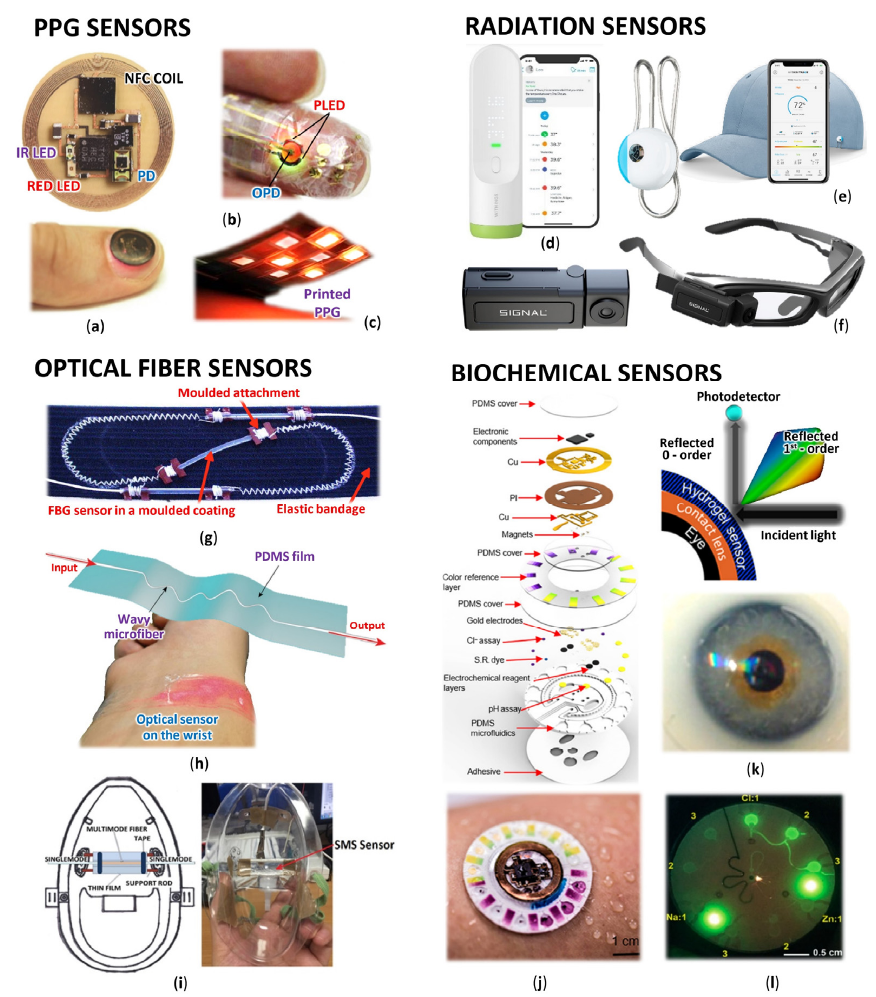
Figure 1. Wearable optical sensors for measuring of human physiology: ( a ) Miniaturized battery- free NFC enabled wireless systems for wearable pulse oximetry (unencapsulated device and